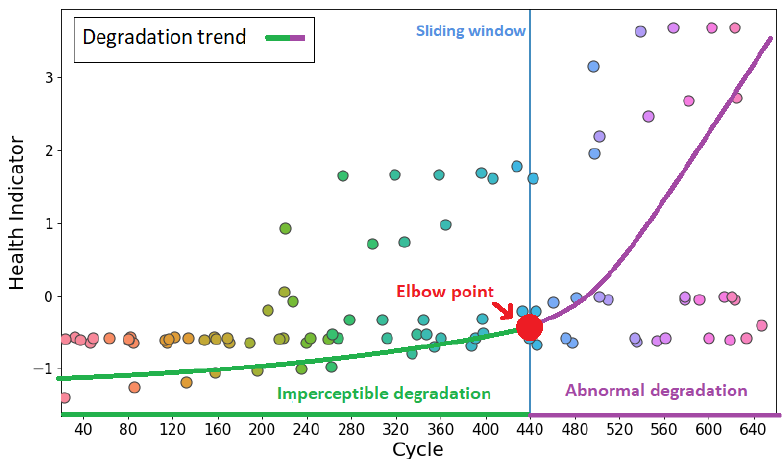
Figure 3. Elbow point detection based on sliding window.